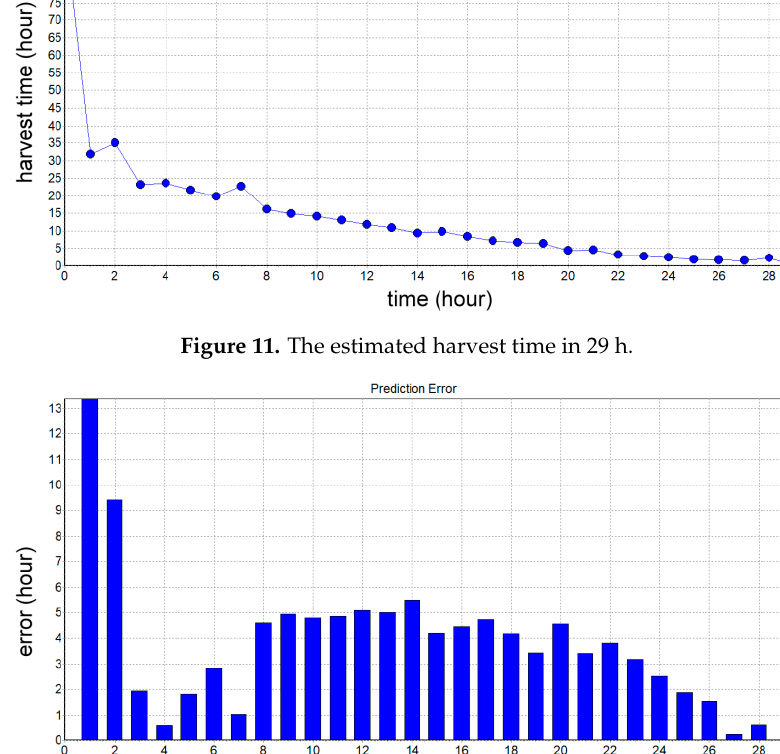
Figure 12. The errors of the estimated harvest time.